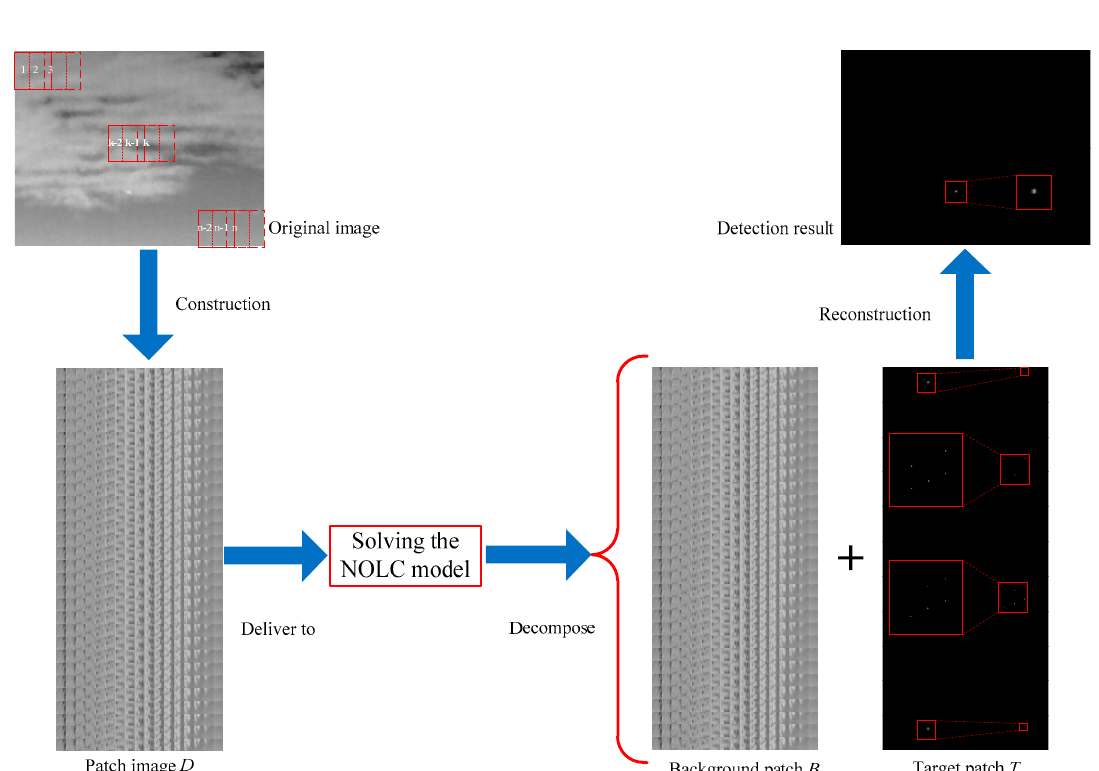
Figure 4. Detection flow of NOLC model.